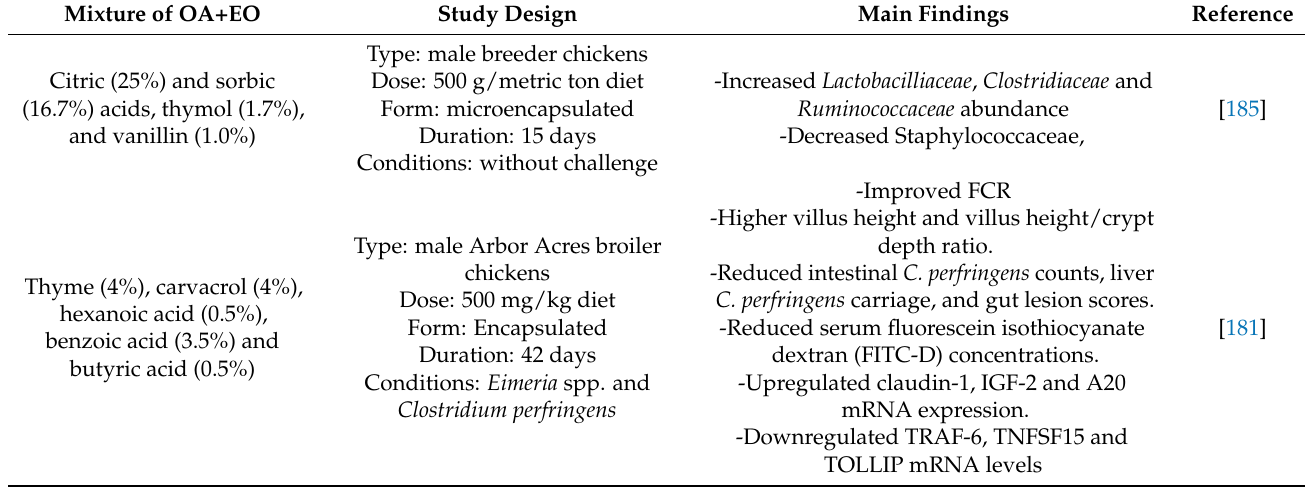
Table 7. Application of mixtures of phytogenics and organic acids with major physiological responses in poultry. Mixture of OA+EO Study Design Main Findings